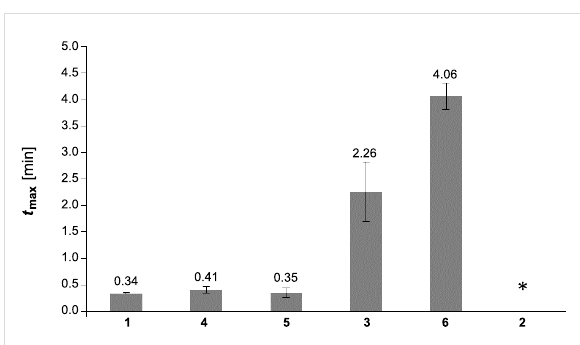
Figure 1: Refractive indices (RI) and viscosities ( η ) of crosslinkers 1–6 (* solid at room temperature).